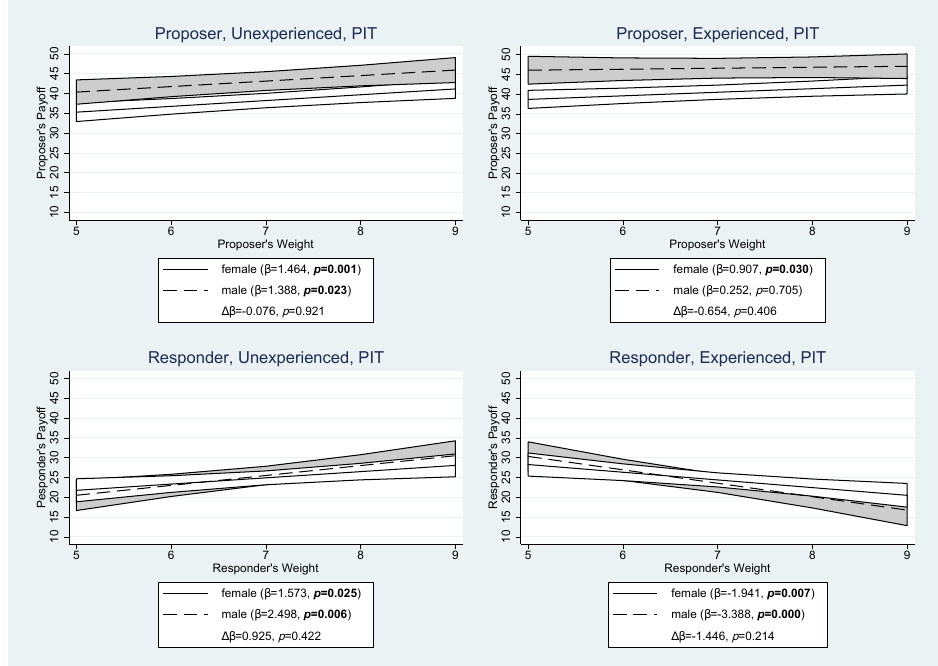
Figure 2. Marginal Effect of Nominal Voting Weight in P IT by Role, Experience, and Gender. β and ∆ β are the marginal effect of the nominal voting weight and the differential slope of Gender { 1 = male } estimated by a random effects Tobit regression including controls for age, siblings, lab experience, field of study, and dummies for employment and “break” (see Section 2.2). p is the significance level. Shaded areas represent 90% confidence intervals around the